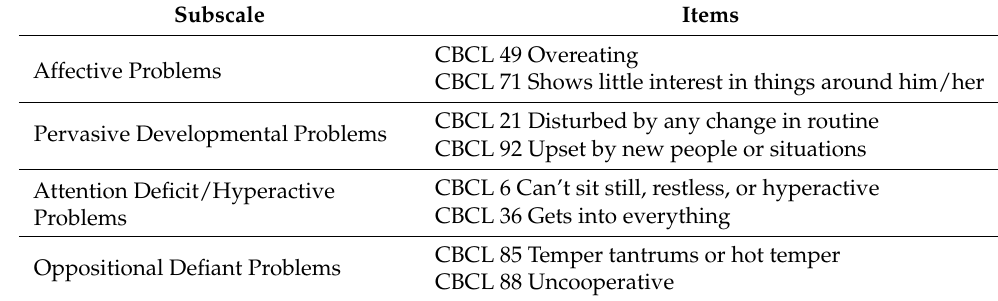
Table 3. DIF items on each